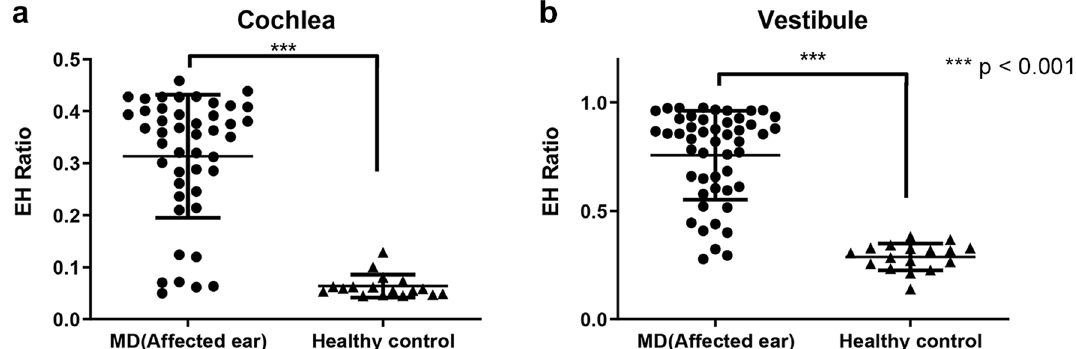
Figure 1. Endolymphatic hydrops (EH) ratios analyzed from histopathology images. In both cochlea ( a ) and vestibule ( b ), the EH ratio of the affected ear was significantly higher (p < 0.001) than that of the healthy control